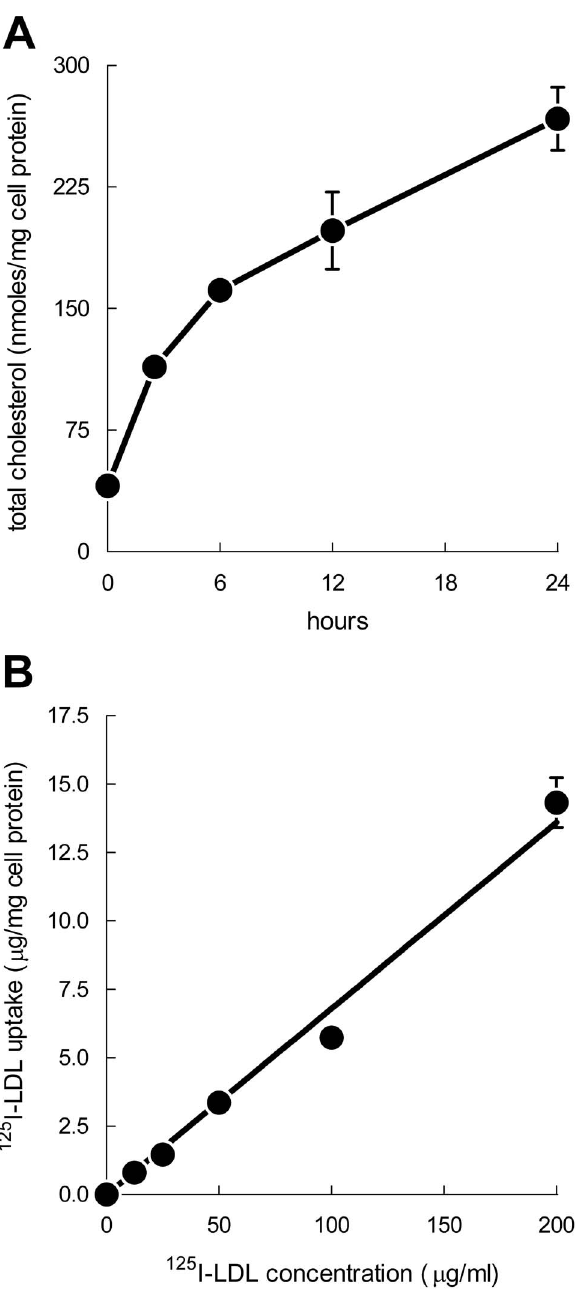
Figure 2. Macrophage uptake of 125 I-LDL is non-saturable. A. LDLR 2 / 2 macrophages were incubated with 1 mg/ml of LDL for 0– 24 h and cholesterol accumulation was then assessed. B. LDLR 2 / 2 macrophages were incubated 24 h with increasing concentrations of 125 I-LDL, and then 125 I-LDL uptake was assessed. Uptake values represent the sum of cell-associated and degraded 125 I-LDL. The range of cell-associated and degraded 125 I-LDL was 7–13% and 87–93%, respectively.